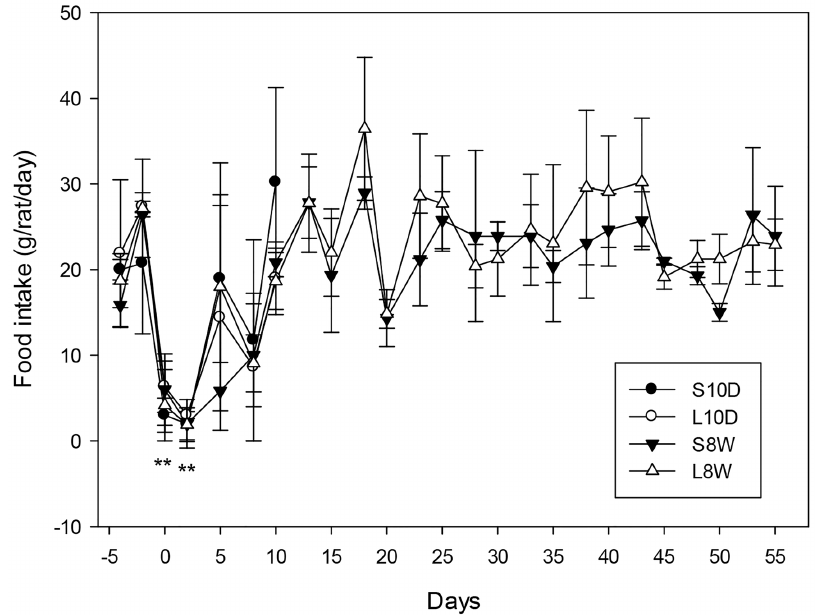
Figure 2. Changes in daily food intake. The food intake was quantified every two or three days and calculated as mass of food consumed daily per rat 4 days before and 55 days after the operation (day 0). * p , 0.05, ** p , 0.01: significantly lower than the other time points as analyzed by One- way RMANOVA. One-way ANOVA was used to analyze the significance among four groups and student t-test was used between two groups at each time point.